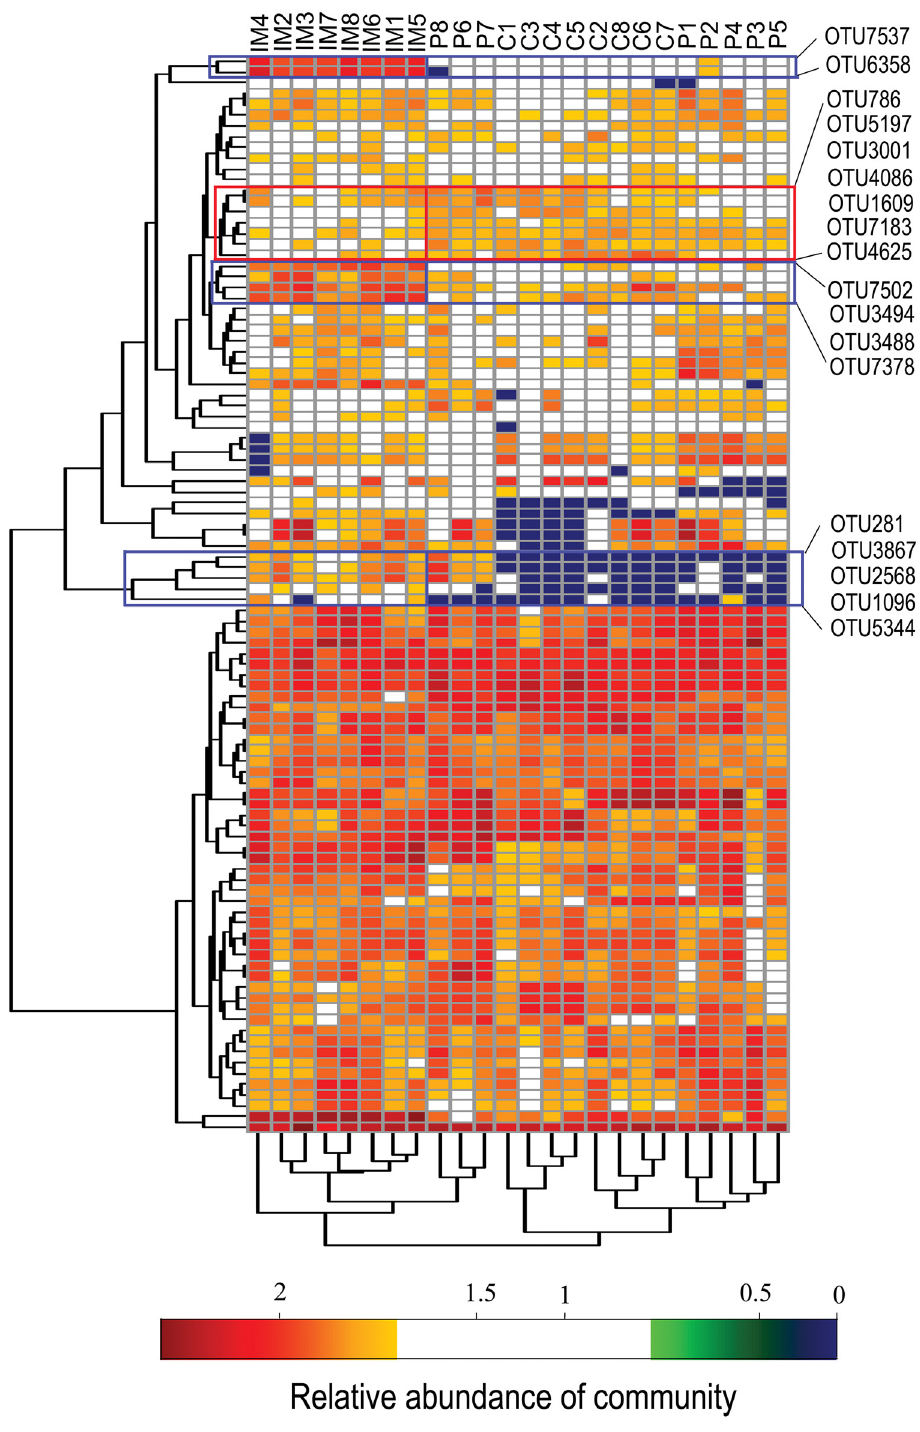
Fig 4. Heat map profiles and dendrograms of the most abundant OTUs in the gut microbiota for all samples. Experimental groups: control, probiotics, and intestinal microbes. Color represents relative